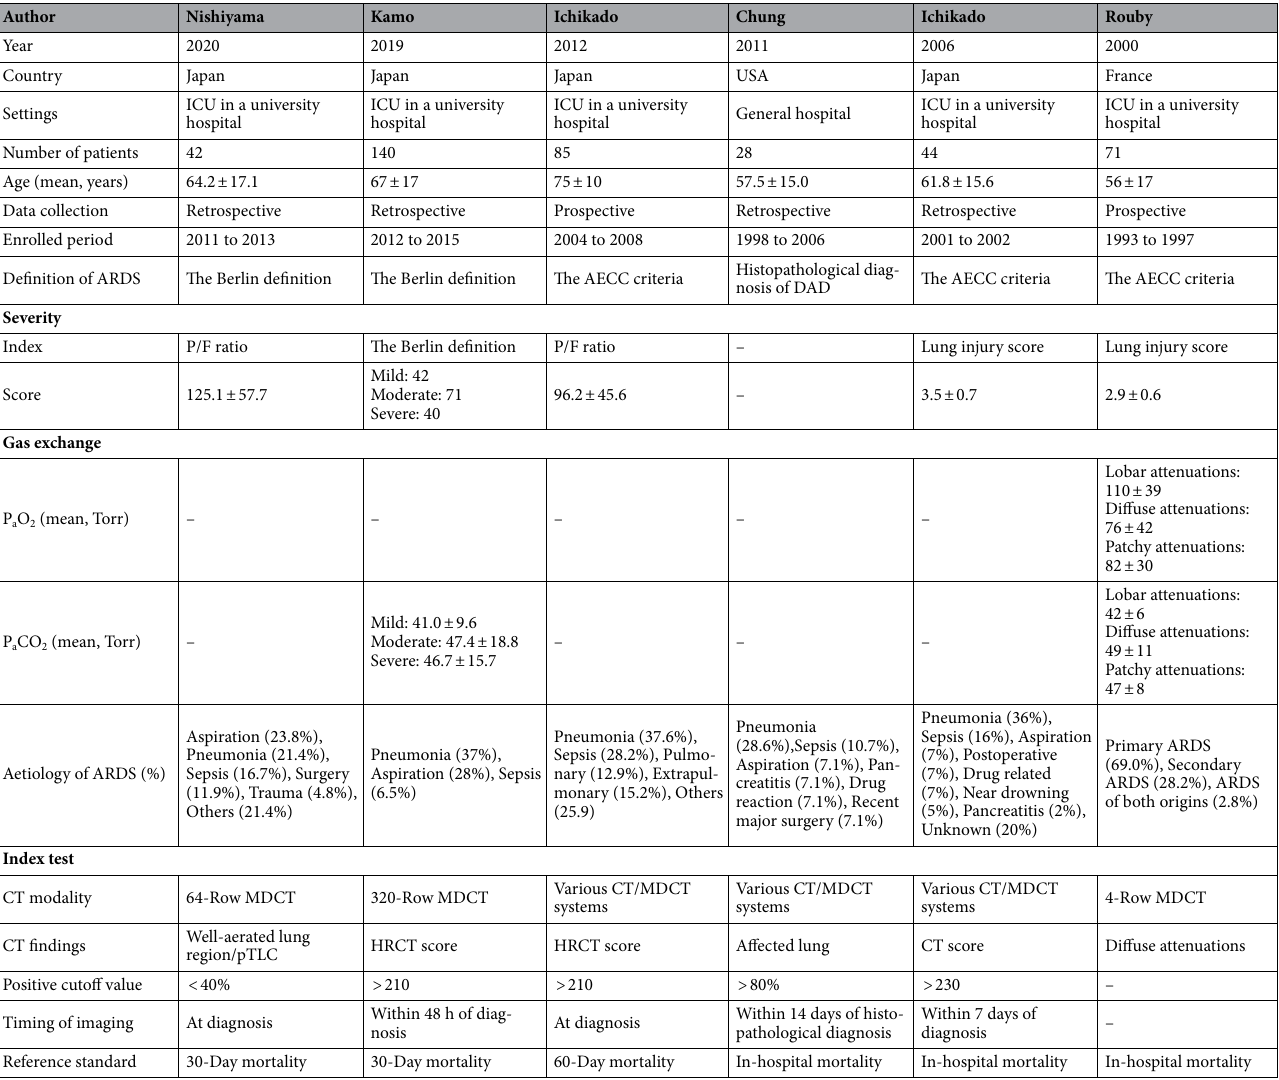
Table 1. Summary of the primary study characteristics. AECC American–European Consensus Conference, ARDS acute respiratory distress syndrome, CT computed tomography, DAD diffuse alveolar damage, HRCT high-resolution computed tomography, ICU intensive care unit, MDCT multi-detector computed tomography, pTLC predicted total lung capacity, P a O 2 partial pressure of arterial oxygen, P a CO 2 partial pressure of arterial carbon